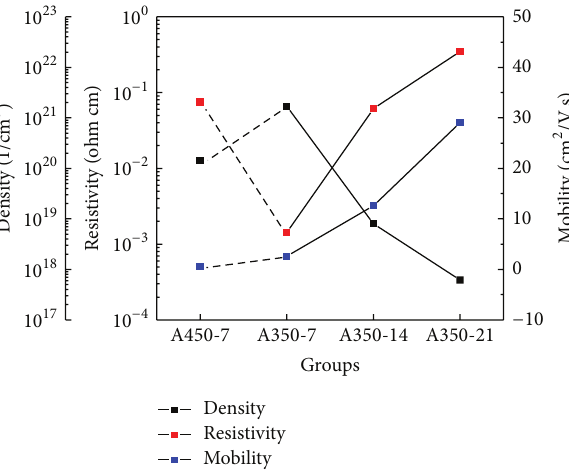
Figure 3: Hall-effect data of the AZO